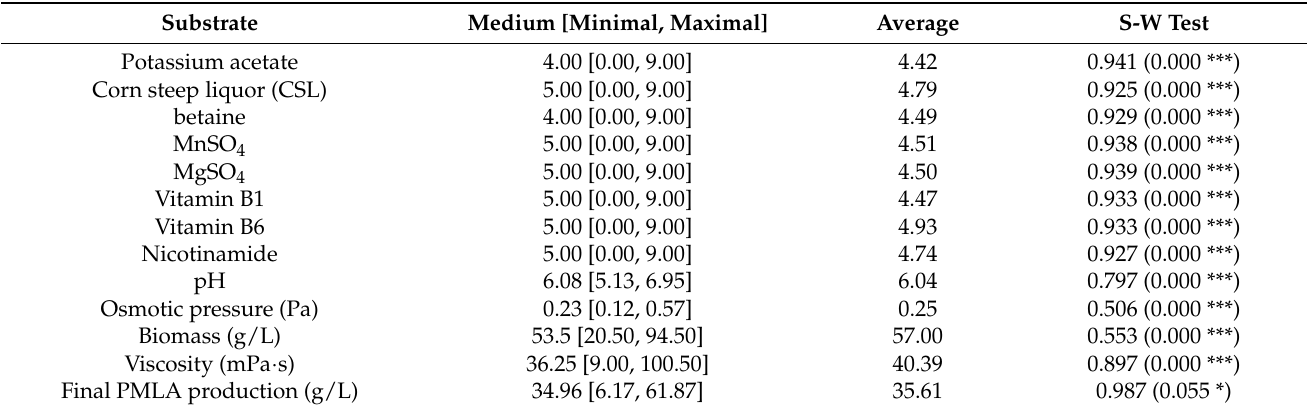
Table 1. The overall description of 212 collected samples of different substrates, secondary indexes, and PMLA production.